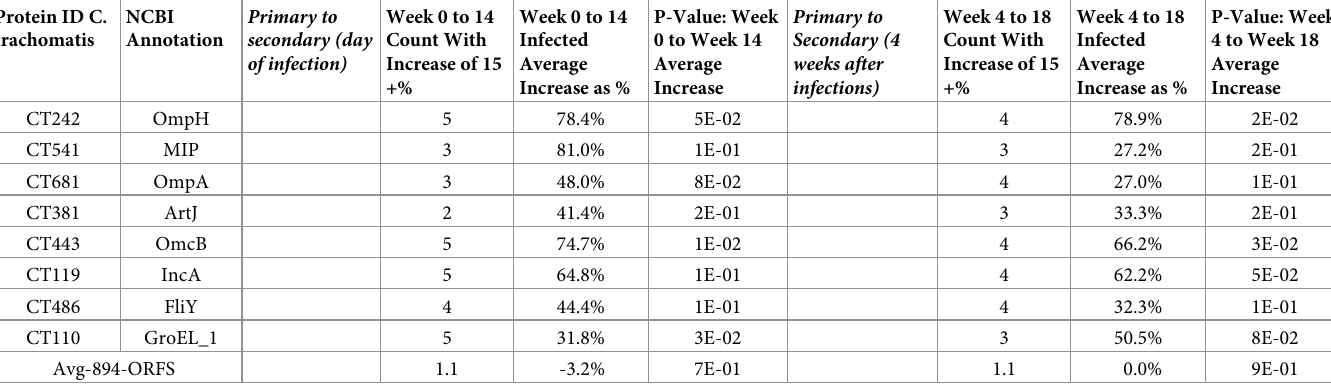
Table 2. Immunodominant antigens: Comparison of primary and secondary infections. Protein ID C.